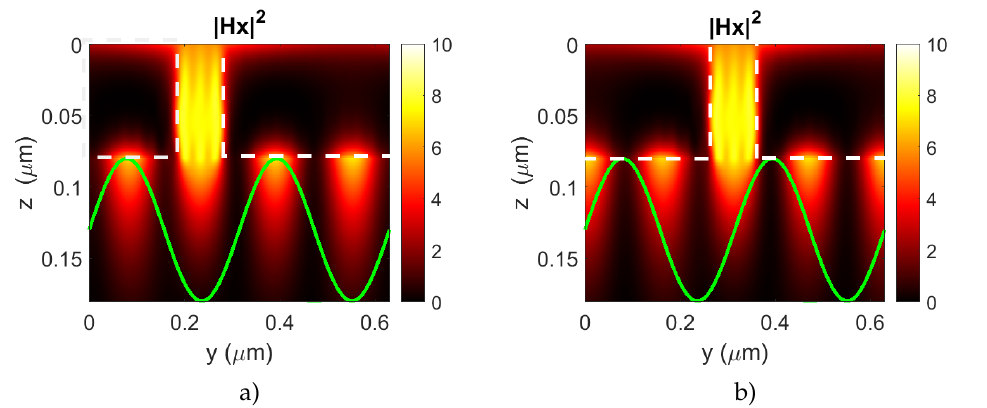
Figure 4. The spatial distributions of the | H x | 2 of the SPP wave and the magnetization modulation (green line) for two different values of phase shift between the plasmonic grating and the magnetiza- tion modulation ( a ) φ = 1.9 rad ( δ T = 0) and ( b ) φ = 2.7 rad ( δ T = 0.15). The magnon wavelength is half of the plasmonic grating period. White dashed lines denote the cross sections of the gold stripes of the plasmonic grating.